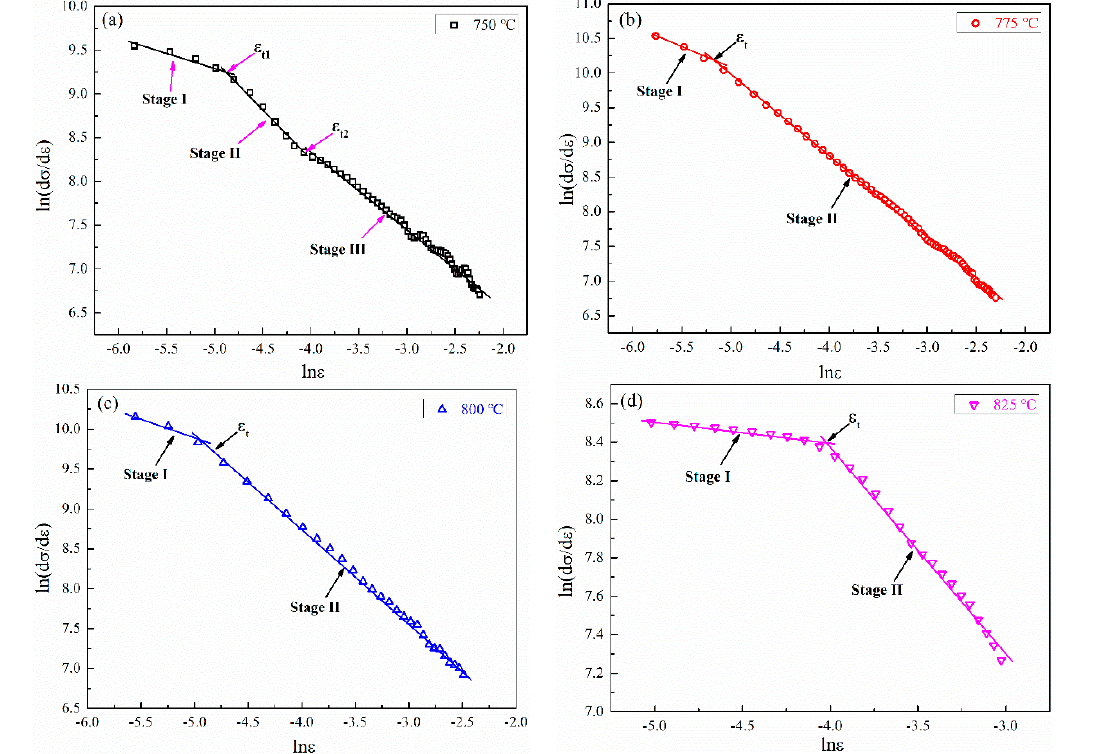
Figure 8. The ln(d σ /d ε ) vs. ln ε plots for the D C-J model of LH800 steel at different austenitizing temperatures: ( a ) 750 °C; ( b ) 775 °C; ( c ) 800 °C; ( d ) 825 °C. Table 3. Parameters related to the work-hardening behavior in the D C-J model of LH800 steel. Austenitizing